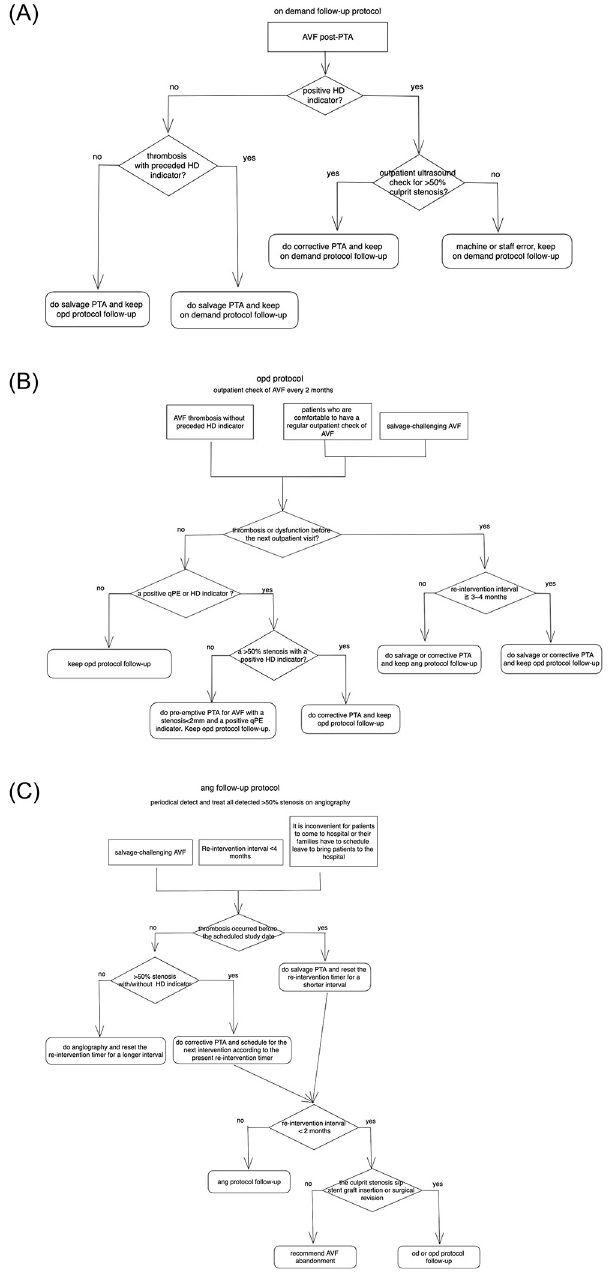
Fig 1. The three follow-up sub-protocols. (A) The on-demand (od) sub-protocol. (B) The outpatient (opd) sub- protocol. (C) The angiographic (ang)